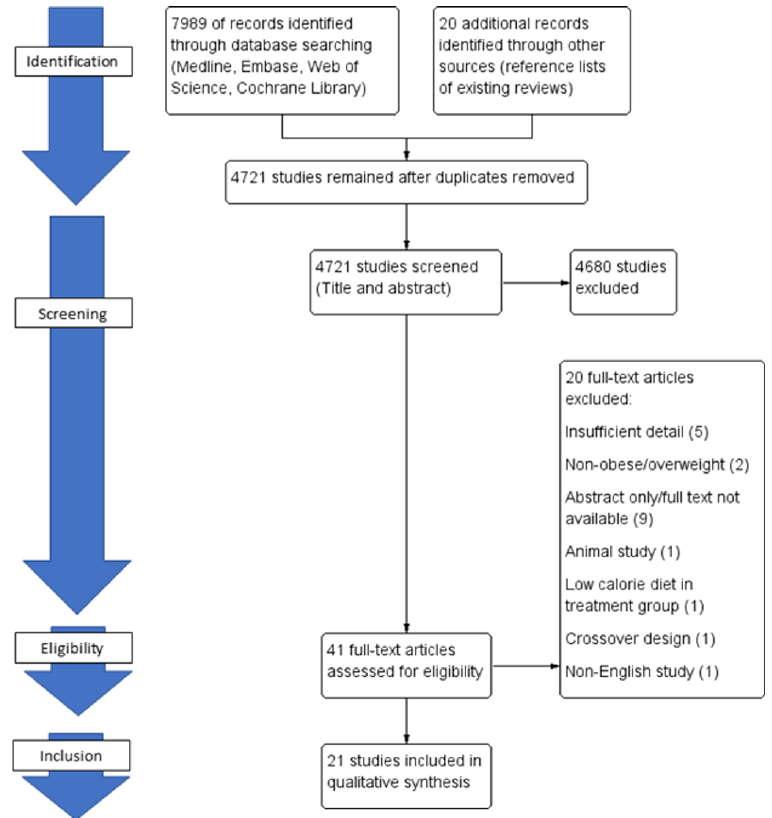
Figure 2. Study flow diagram.